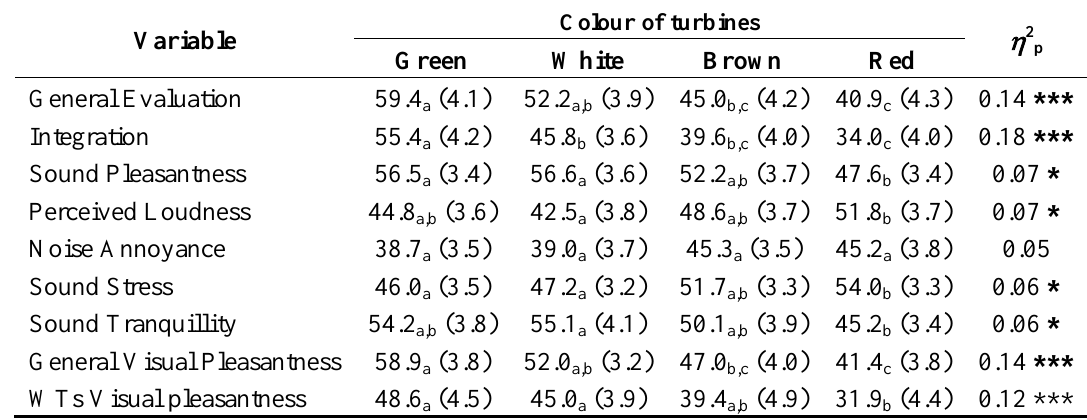
Table 6. Mean values (standard error) and effect size as a function of the Colour of